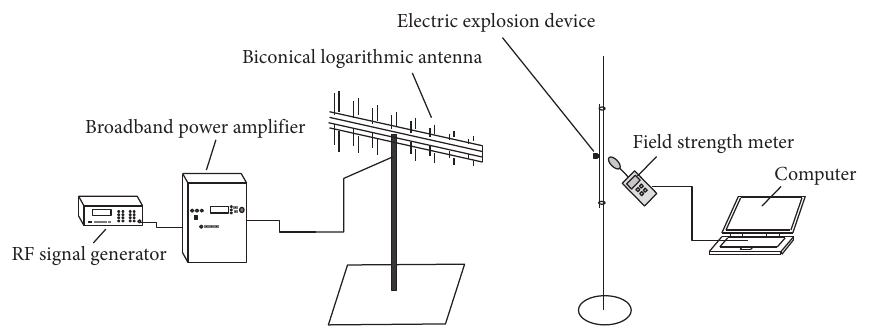
Figure 6: Schematic diagram of the EED ignition excitation under electromagnetic